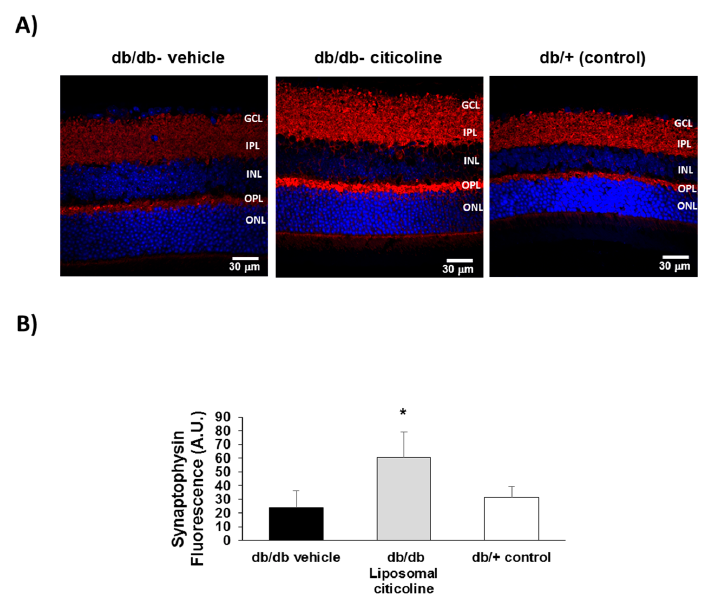
Figure 6. Effect of citicoline on synaptophysin. ( A ) Comparison of synaptophysin immunofluorescence (red) between representative samples from a db/db mouse treated with vehicle, a db/db mouse treated with citicoline, and a non-diabetic mouse. Nuclei were labeled with Hoechst (blue). ONL: outer nuclear layer; OPL: outer plexiform layer; INL: inner nuclear layer; IPL: inner plexiform layer; GCL: ganglion cell layer; ( B ) Quantification of synaptophysin immunofluorescence in arbitrary units (AU). Results are mean ± SD. * p < 0.01 vs. the other groups.